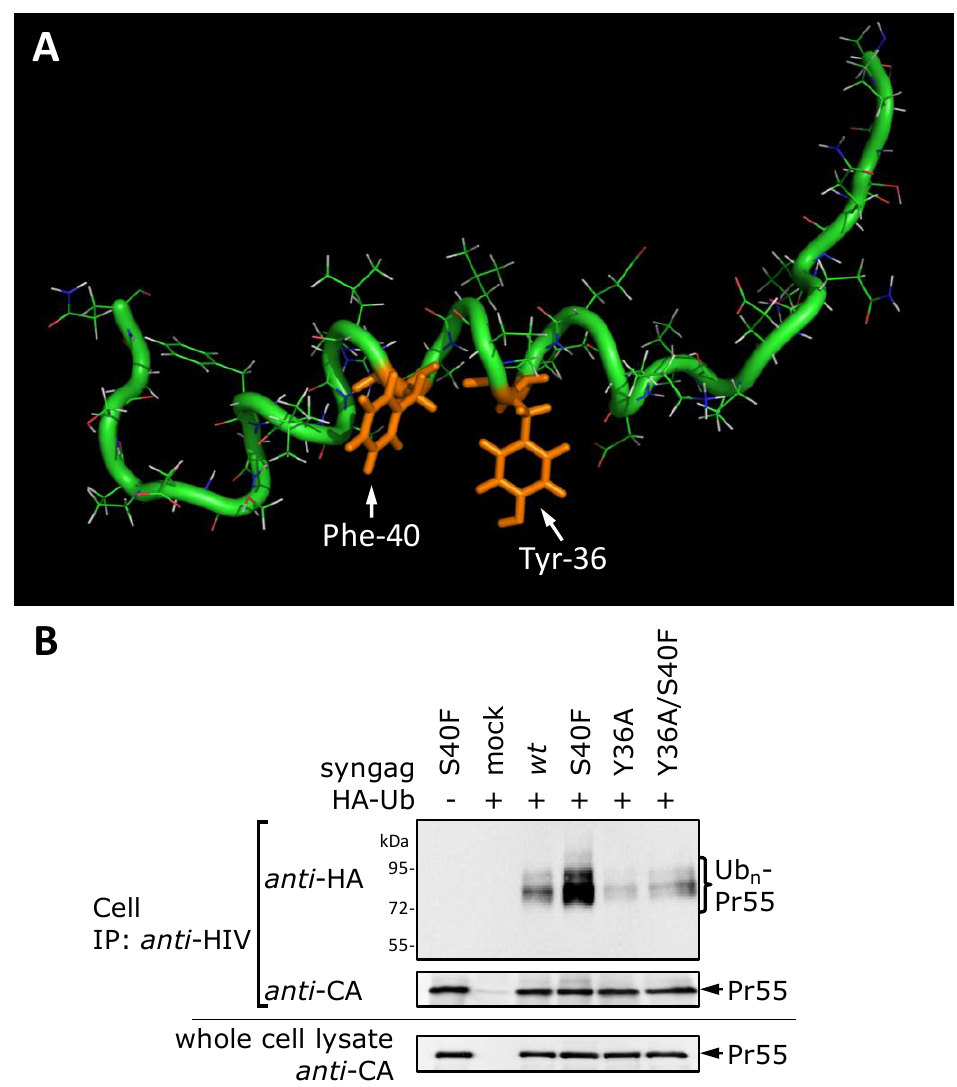
Figure 9. NMR structure of p6(23-52)S40F confirms formation of a new hydrophobic domain. ( A ) Structure of s p6(23-52)S40F determined by NMR spectroscopy. The